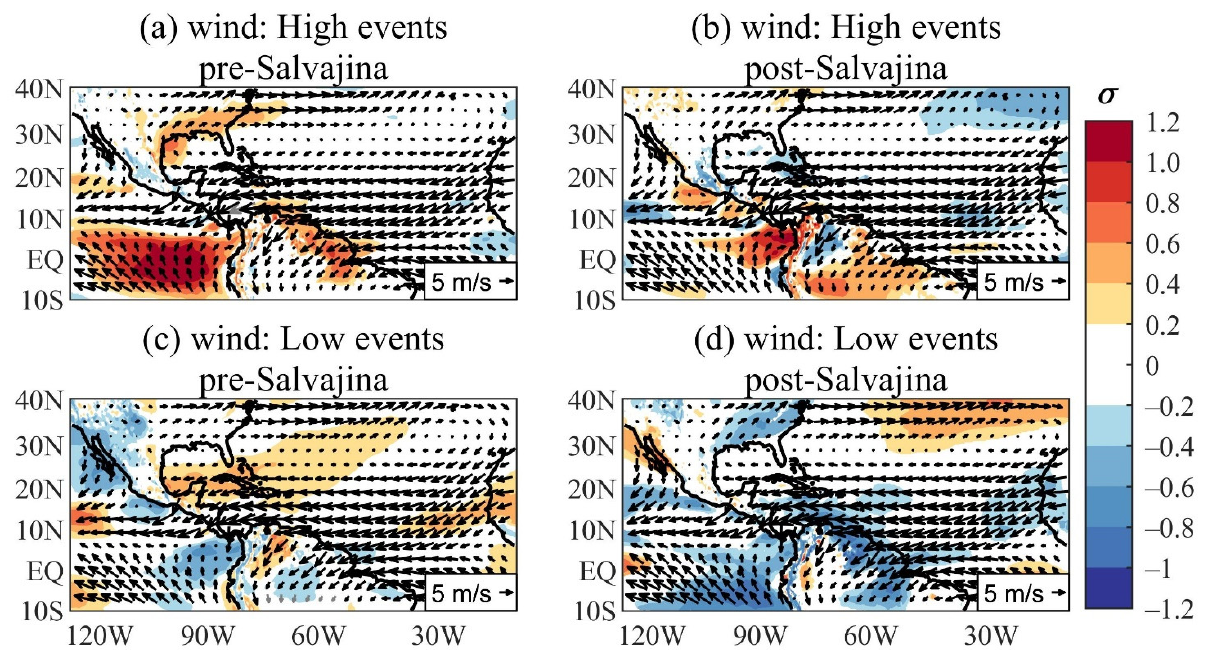
Figure 7. Composites of 925 hPa wind vector (m/s) and zonal wind standardized anomalies for November–January during: ( a ) high discharge events pre-Salvajina; ( b ) high discharge events post-Salvajina; ( c ) low discharge events pre-Salvajina; and ( d ) low discharge events post-Salvajina. Shading interval: 0.2 SD. Shaded areas indicate significant zonal wind anomalies at the 95% confidence level based on Student’s t-test. Vectors in bold indicate significant magnitudes at 95% confidence level based on ‘Student’s t -test. The arrow at the bottom of these panels illustrates the base magnitude of the wind vector in m/s.